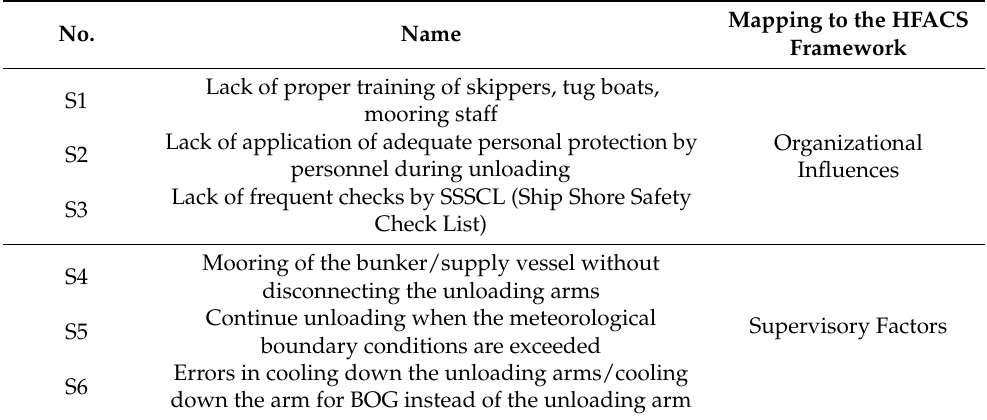
Table 8. Analyzed